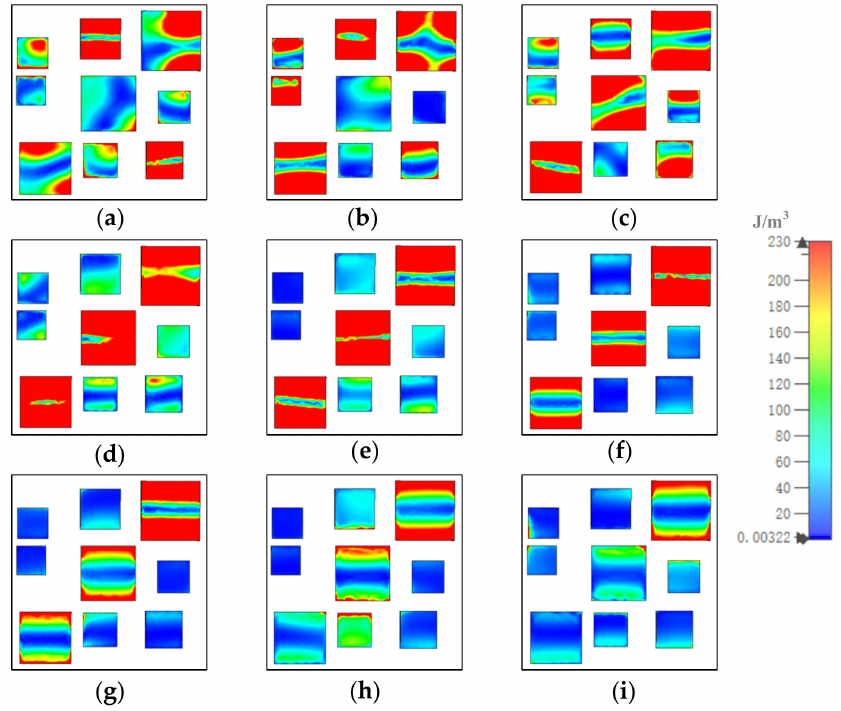
Figure 6. The distribution of electric field energy in middle gold layer at ( a ) 8.5, ( b ) 9.13, ( c )